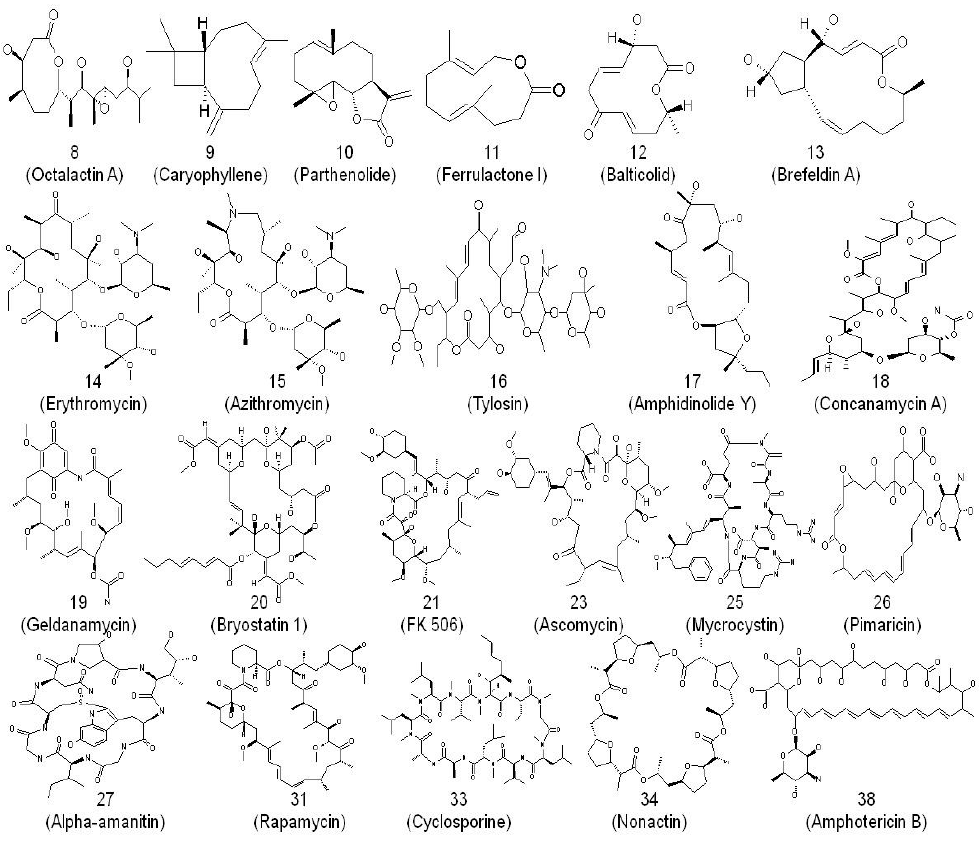
Figure 1. Examples of macrolide diversity [31], where macrocyclic ring lactones vary in size from eight ‐ membered up to 62 ‐ membered rings. Numbers indicate the size of the ring.